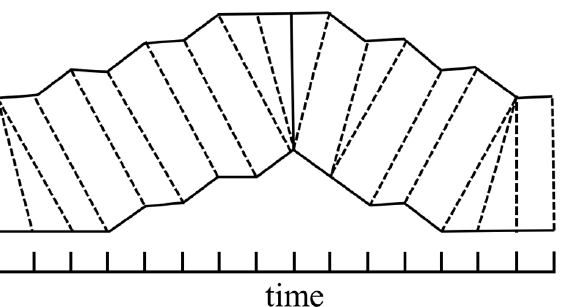
Figure 7. Matching principle of the DTW algorithm. (modified from Salvador and Chan [36]). Further, the cumulative distance between the two time series can be obtained, as shown in Equation (1). Eventually, the most suitable twist curve minimizes the path’s cu- mulative distance, as shown in Equation (2).